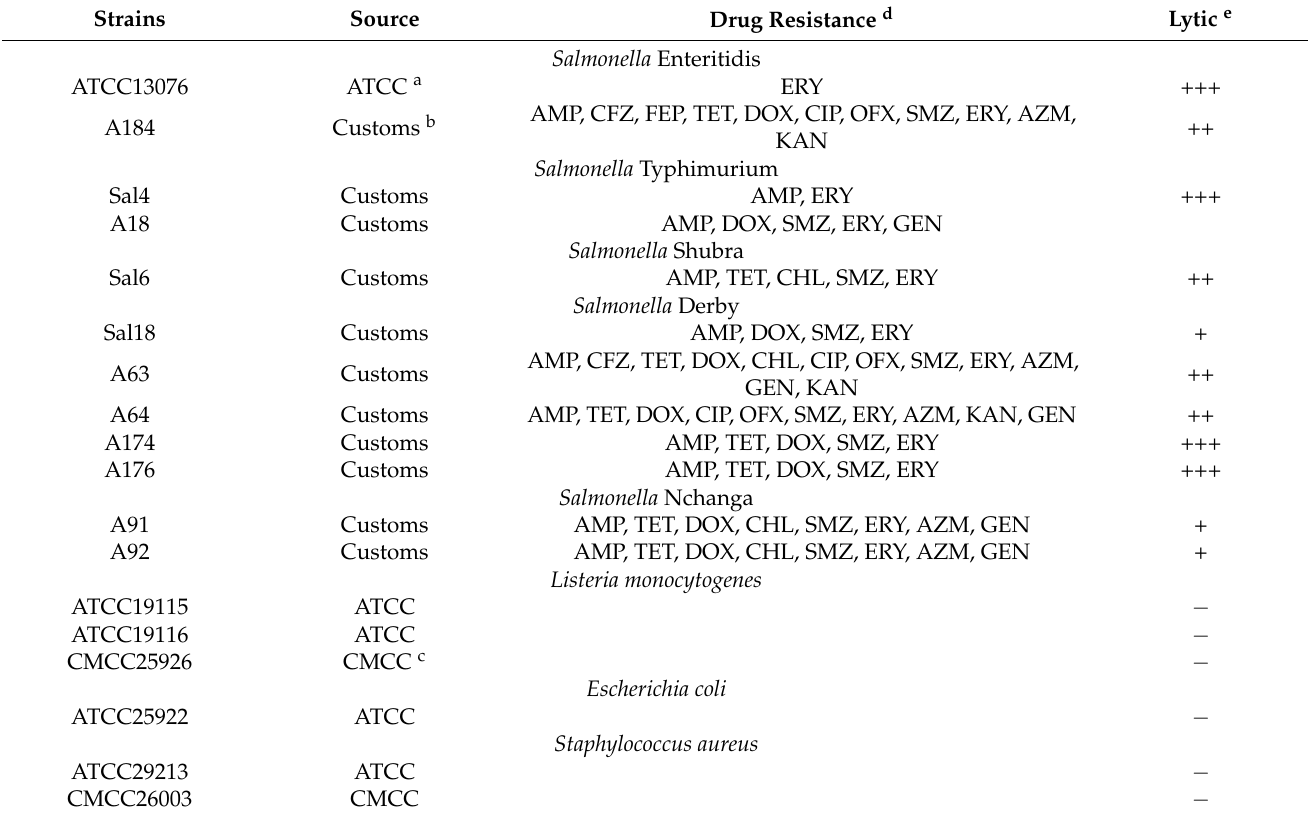
Table 1. Phage SPJ41 lysis